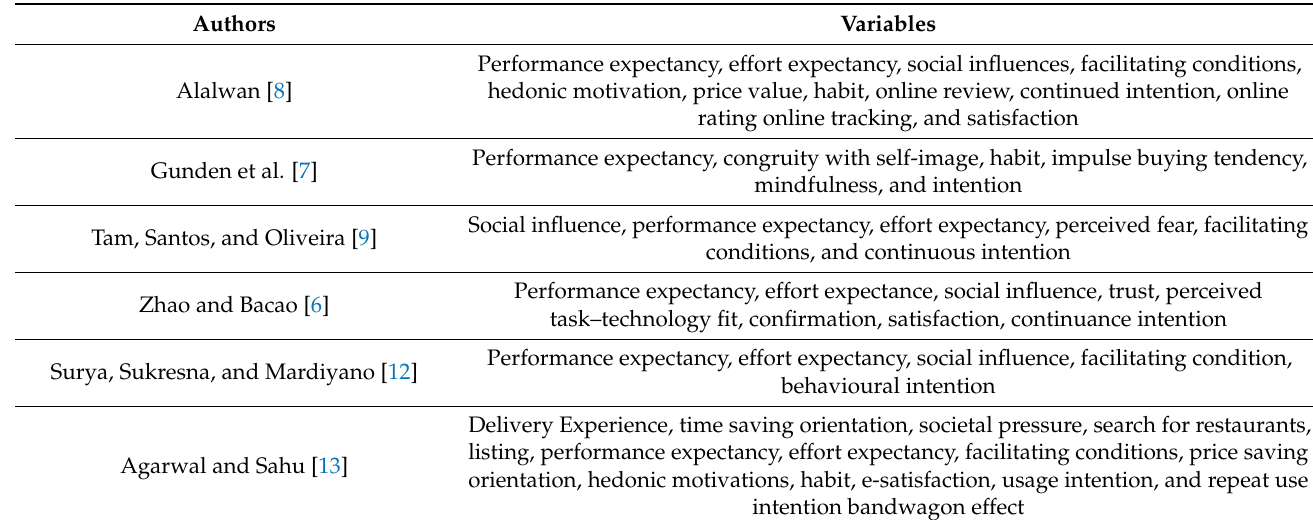
Table 1. Studies on food delivery apps using UTAUT